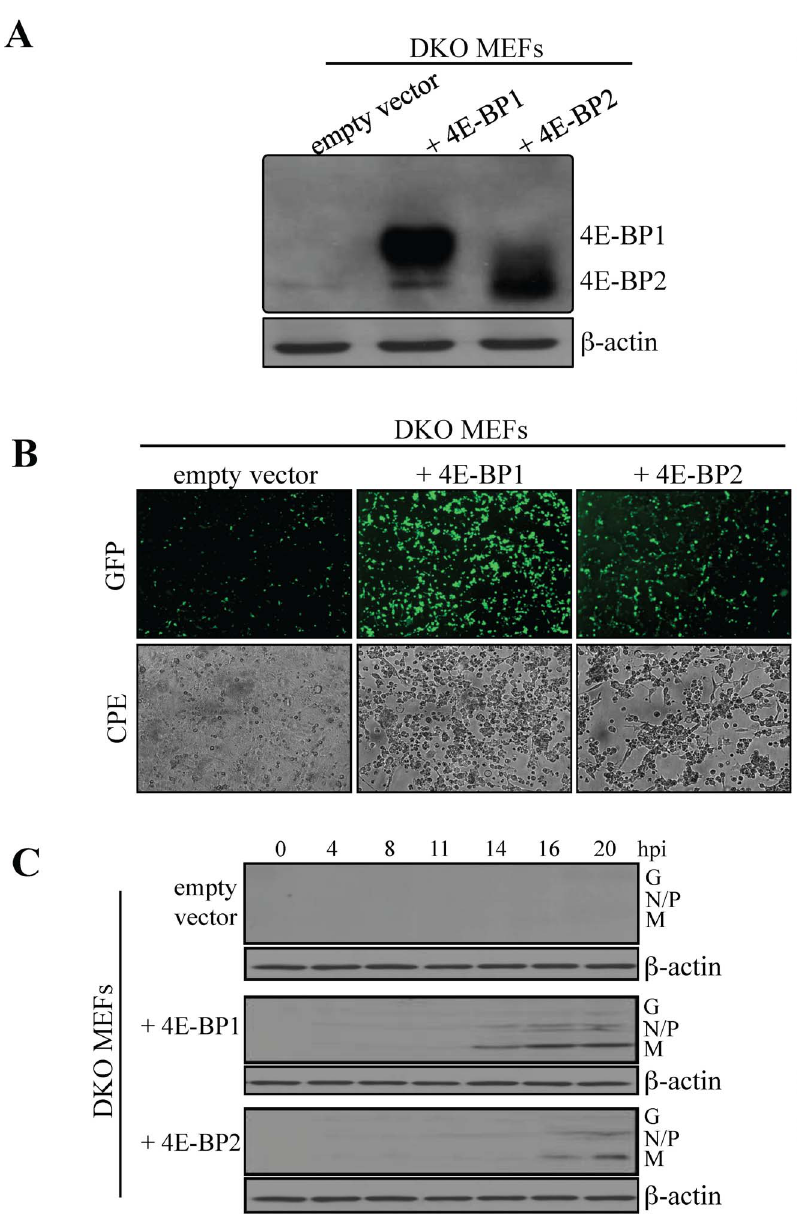
Fig. 4. Exogenous expression of 4E-BP1 or 4E-BP2 in MEFs knockout for both translation repressors augments their susceptibility to VSV infection. (A) 4E-BP1/2 DKO MEFs were transduced with retroviruses expressing either 4E-BP1, 4E-BP2 or an empty vector as control. Western blotting analysis for the expression levels of exogenous 4E-BP1 or 4E-BP2 in DKO MEFs. (B) Control and 4E-BP1- or 4E-BP2- expressing DKO MEFs were infected with VSV-GFP at a MOI of 1 PFU/cell for 24 hours and infection was monitored by GFP fluorescence and CPE. (C) Western blotting analysis for the detection of VSV proteins at the defined time points post-infection with VSV-GFP at a MOI of 1 PFU/cell. b -actin was used as a loading control.